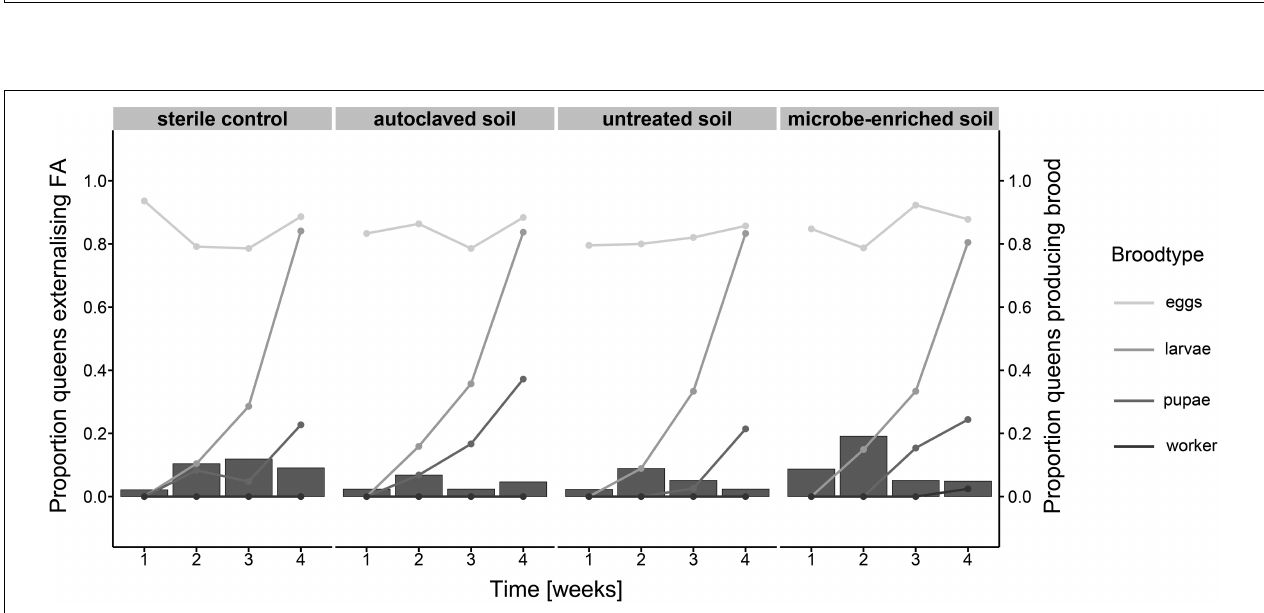
FIGURE 3 | The proportion of queens producing brood after hibernation in the founding experiment. Bars represent the proportion of queens producing eggs, larvae, pupae, and workers under different environmental conditions (sterile control, autoclaved soil, untreated soil, and microbe-enriched soil). Only queens surviving hibernation are taken into account.